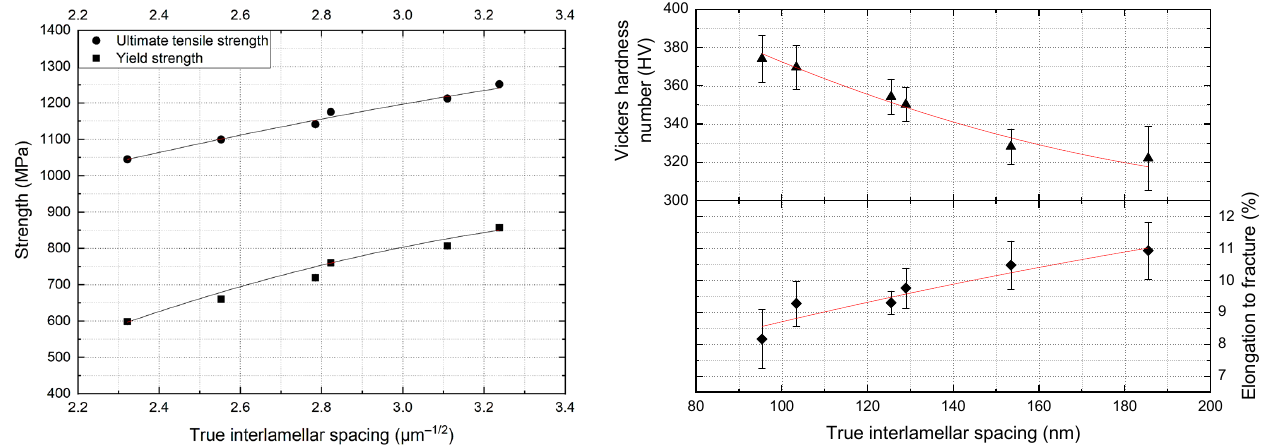
Figure 3. Correlations of tensile properties and Vickers hardness with interlamellar spacing of fully pearlitic steels of group B.